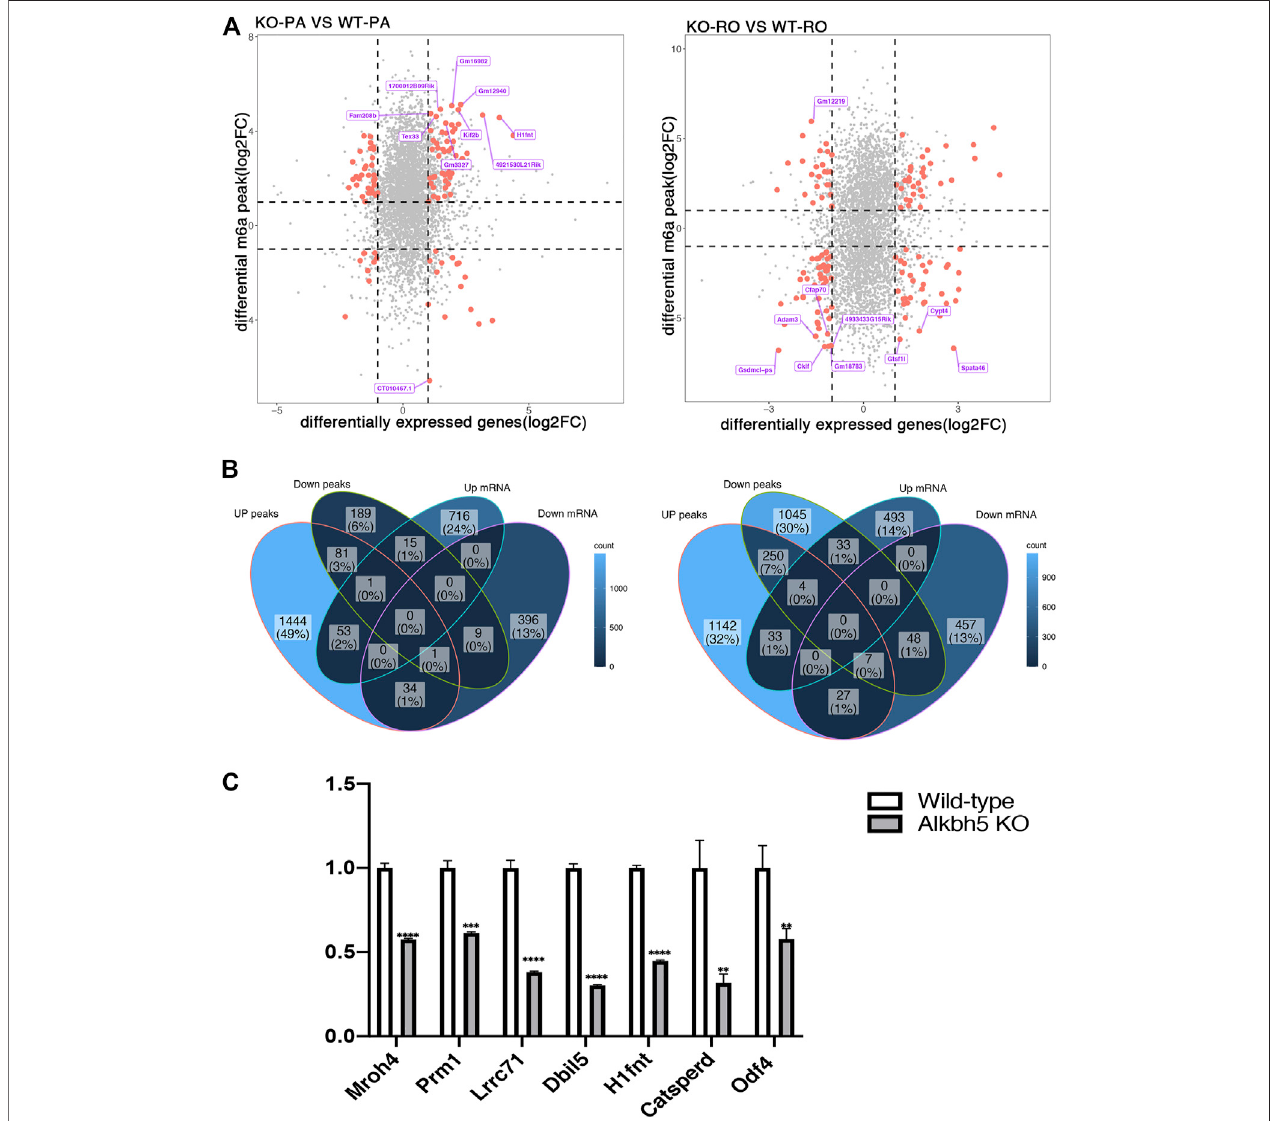
FIGURE 6 | Association analysis of the genes with signi fi cant changes in methylation and mRNA expression level in PA and RO (A) . Venn diagrams showed the intersectionofupregulated and downregulatedmethylationpeaks and mRNAs ofPAand RO respectively (B) . mRNAexpression level ofseven genes in Alkbh5 -KO and WT mice Testicular tissue detected by qPCR (**** p < 0.0001, *** p = 0.0001, ** p < 0.01.) (C)